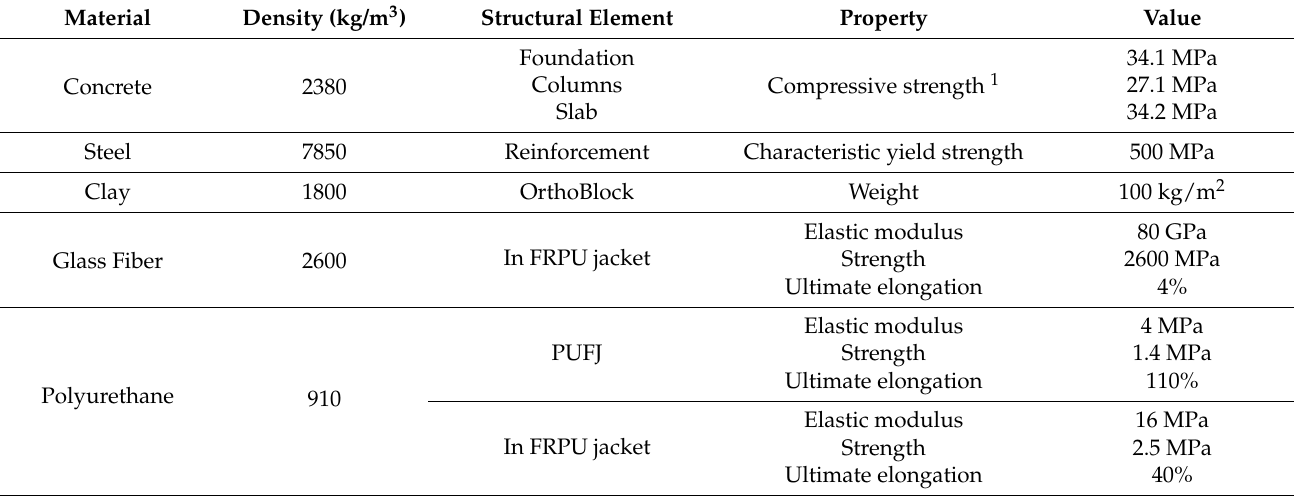
Table 2. Material properties of the infilled RC